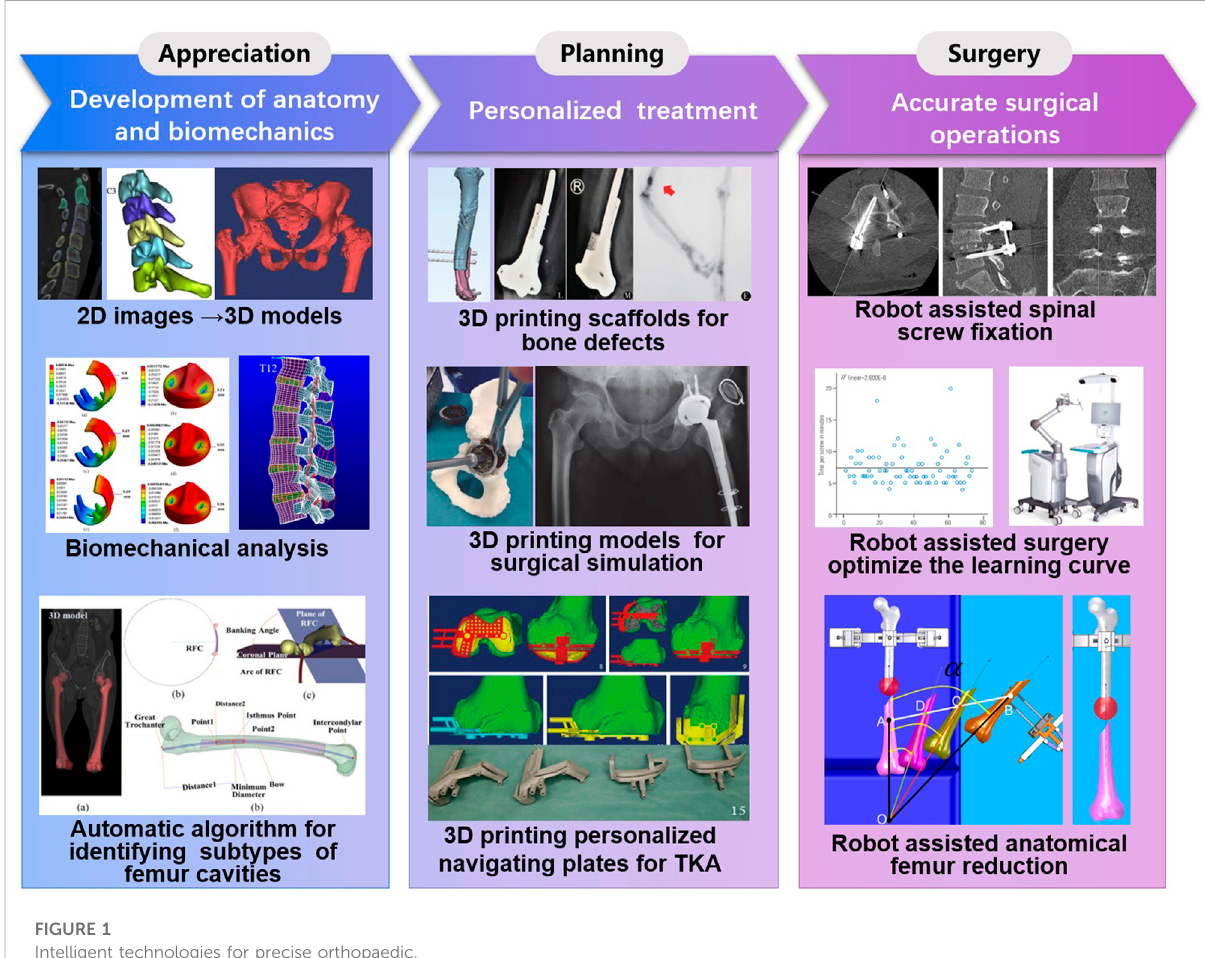
FIGURE 1 Intelligent technologies for precise